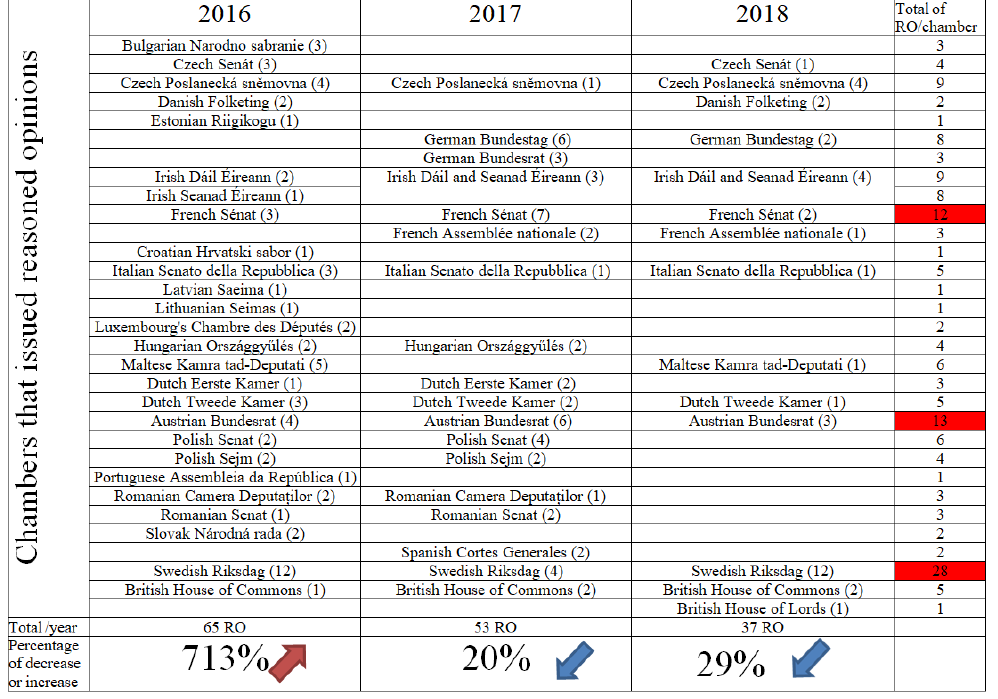
Figure 4. The number of reasoned opinions (RO) issued per chamber (2016–2018). Source: own elaboration based on information available in the annual reports of the European Commission for 2016, 2017 and 2018.